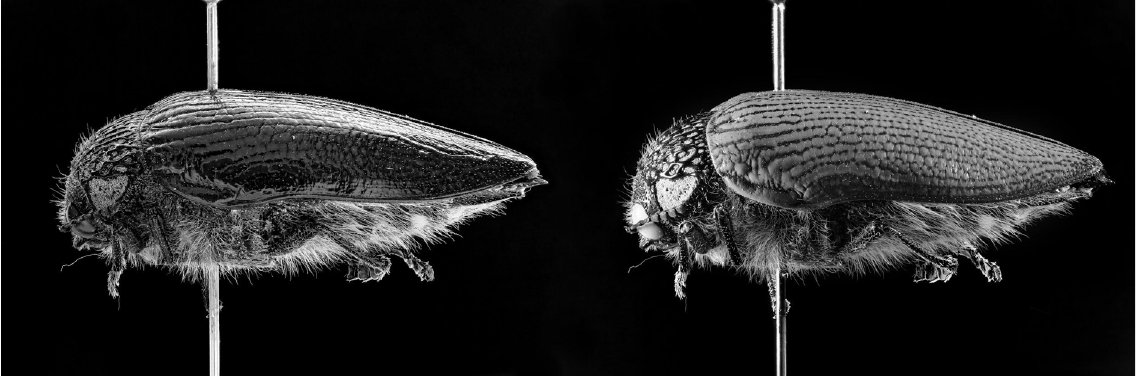
Fig. 4.7. Enhancing the legibility of a specimen. The picture on the left represents the specimen captured under white light, while the picture on the right displays the specimen under UV light. Part of the reflections is reduced under UV light allowing to display more contrasted